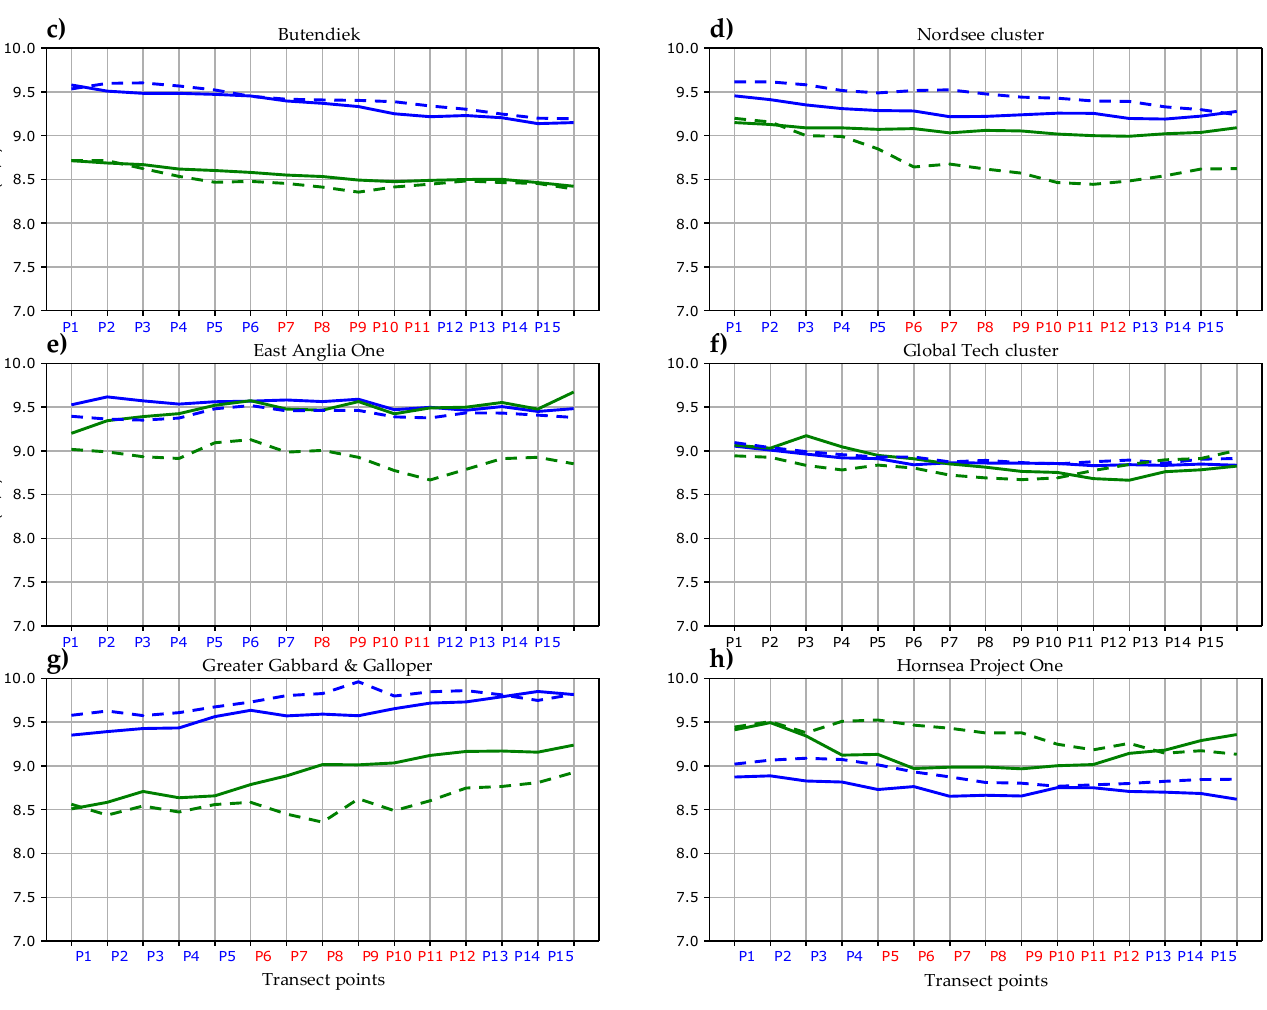
Figure 8. Mean wind speed ( U ) for southerly winds over the OWFs and clusters. See Figure 4 for the line definitions. Note that the figure axes are different than for the corresponding plots for westerly and easterly winds as we have chosen to match the layout of transects in Figure 3. ( a ) Anholt; ( b ) Horns Rev cluster; ( c ) Butendiek; ( d ) Nordsee cluster; ( e ) East Anglia One; ( f ) Global Tech cluster; ( g ) Greater Gabbard & Galloper; ( h ) Hornsea Project One.